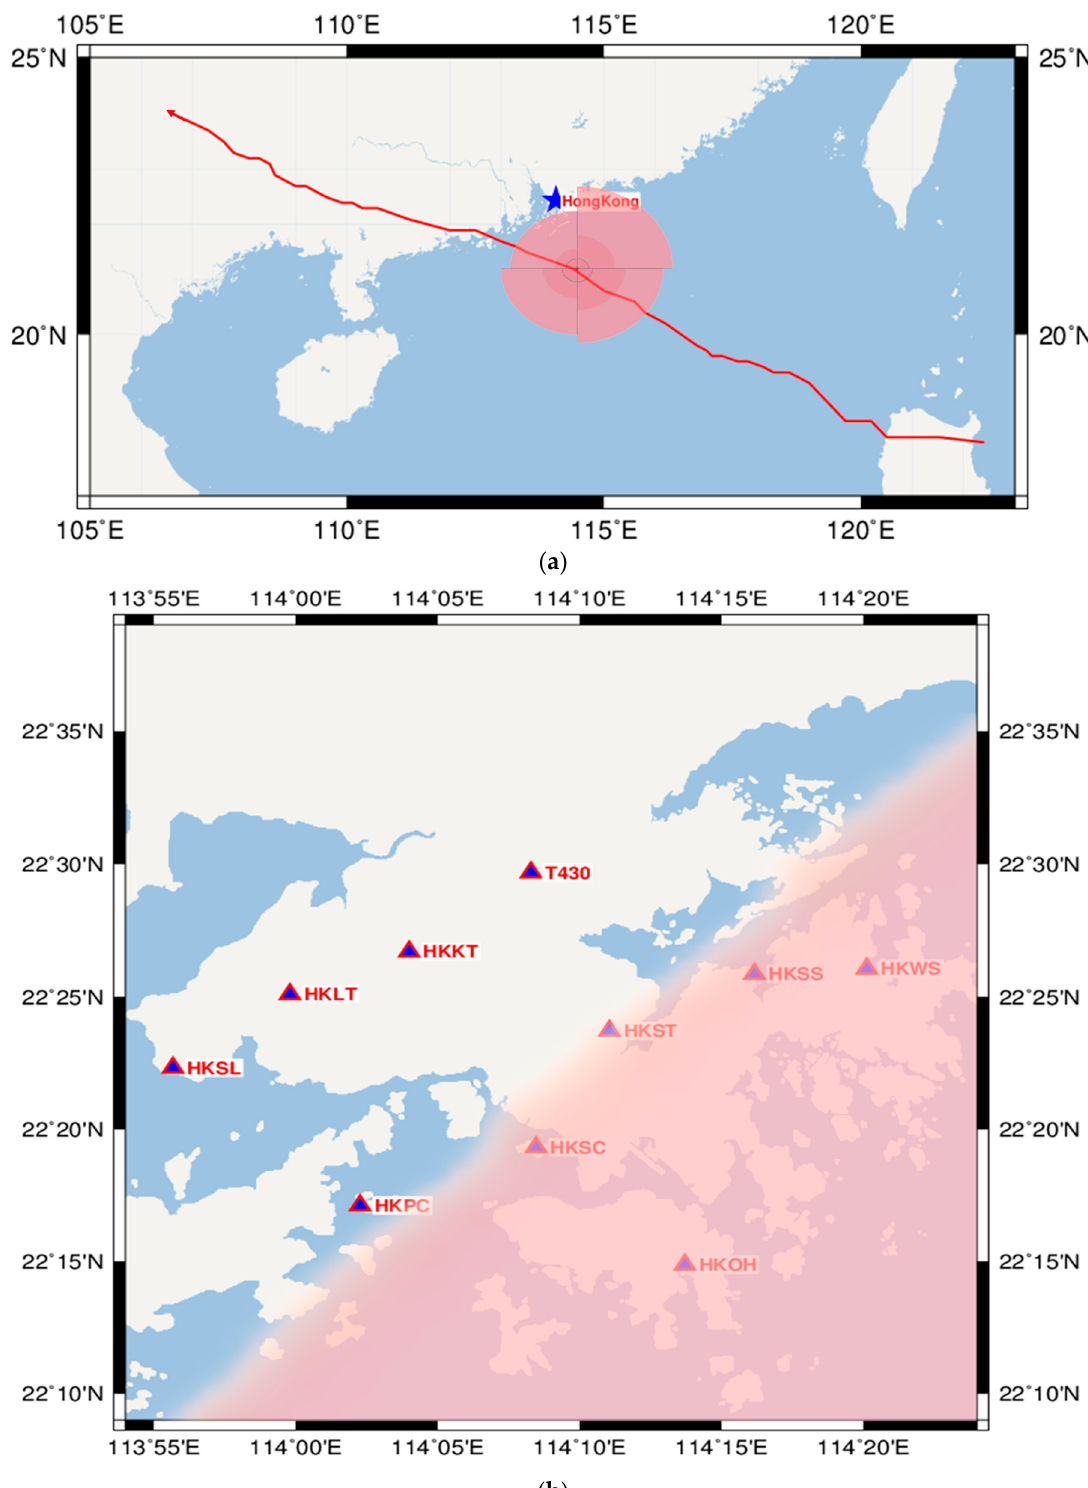
Figure 15. ( a ) Radii of the wind circles in different directions and movement path of Mangkhut typhoon. ( b ) Edge of the typhoon when it passed the Hong Kong area.